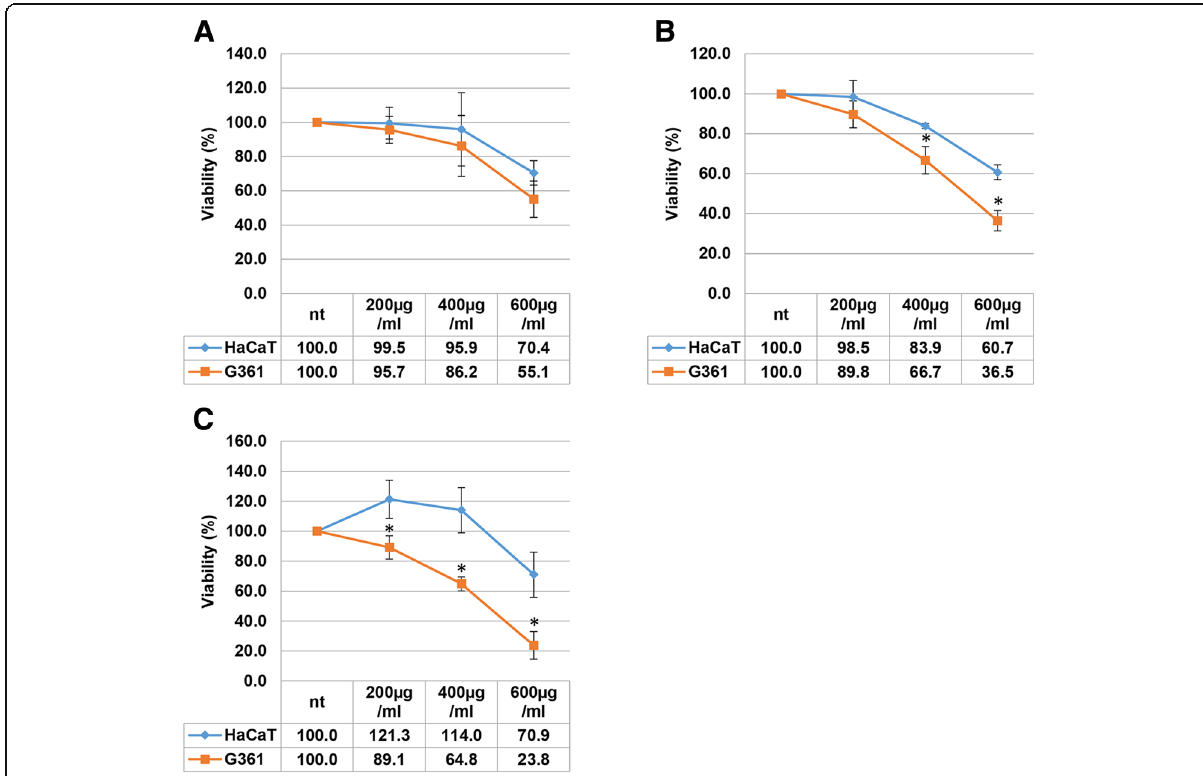
Fig. 2 Long-term effects of ARE on the growth of G361 and HaCaT cells. The growth of G361 and HaCaT cells were monitored at 24 ( a ), 48 ( b ), and 72 h ( c ) after ARE treatment at concentrations of 200, 400, and 600 μ g/ml using the SRB growth assay. Data represent the mean ± SEM ( n = 4). The significant difference between HaCaT and G361 cells were marked as * ( p <